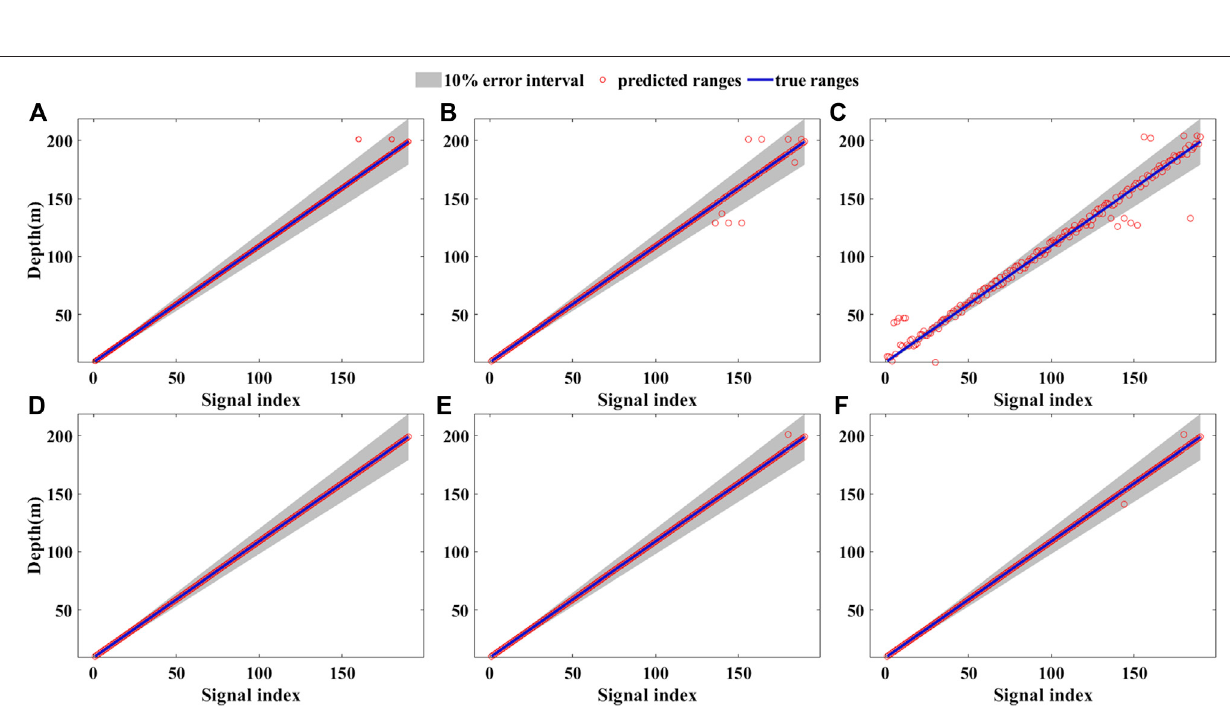
Frontiers in Physics |